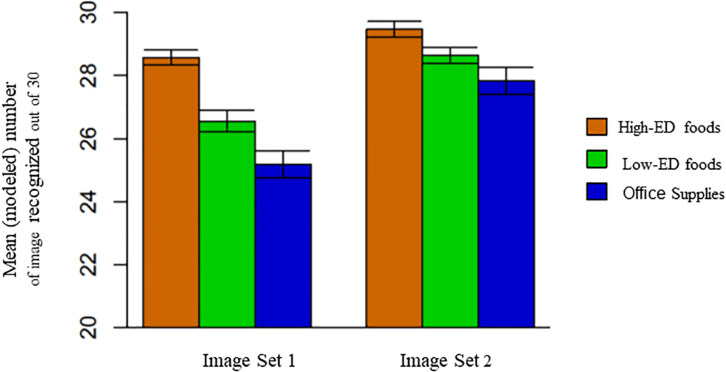
Children’s recognition of 30 high-ED food images. 30 low-ED food images. and 30 office supply images between Image Set 1 and Image Set 2 of the images. Improvements in image recognition were attributable to improvements made in recognition of low-ED foods and office supplies not high-ED foods [version × image category interaction term: P < 0.000 1: F(2gg) = 12.53].